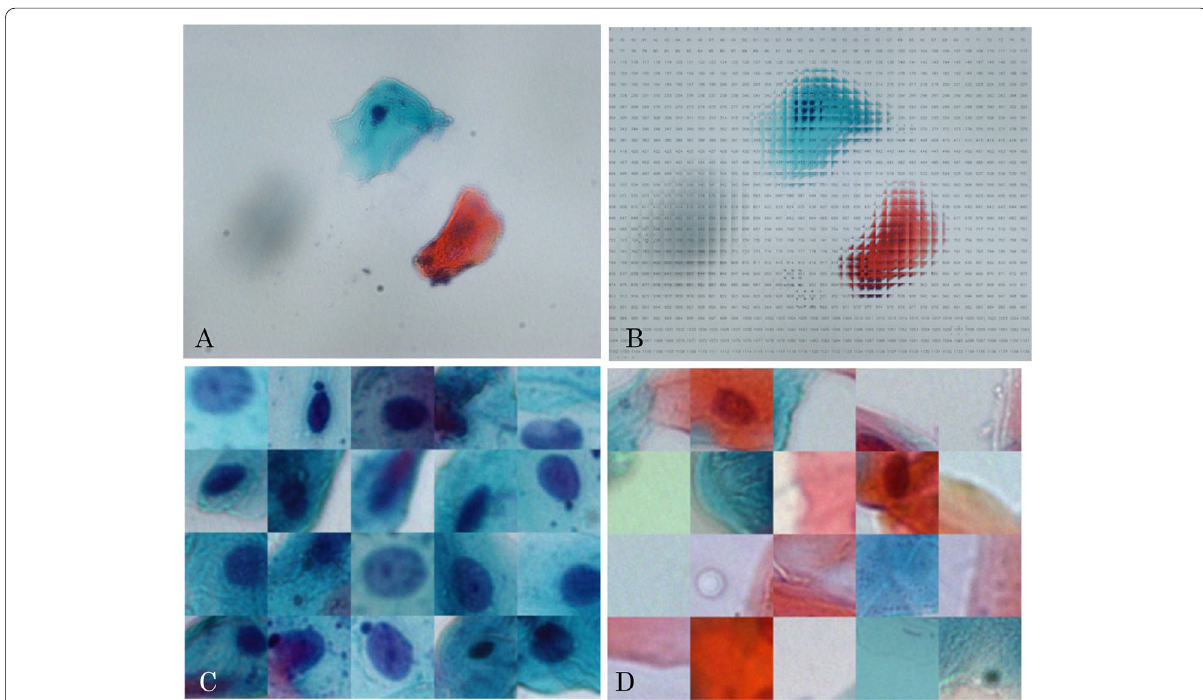
Fig. 1 Dataset preparation for the sliding window method (SWM). A Original image of liquid-based oral cytology (1280 applied. The size of the sliding window is 96 96 pixels. One window contains the cell nucleus, while another window does not. C Images of × windows containing only the cell nuclei. D Example of a window without a cell